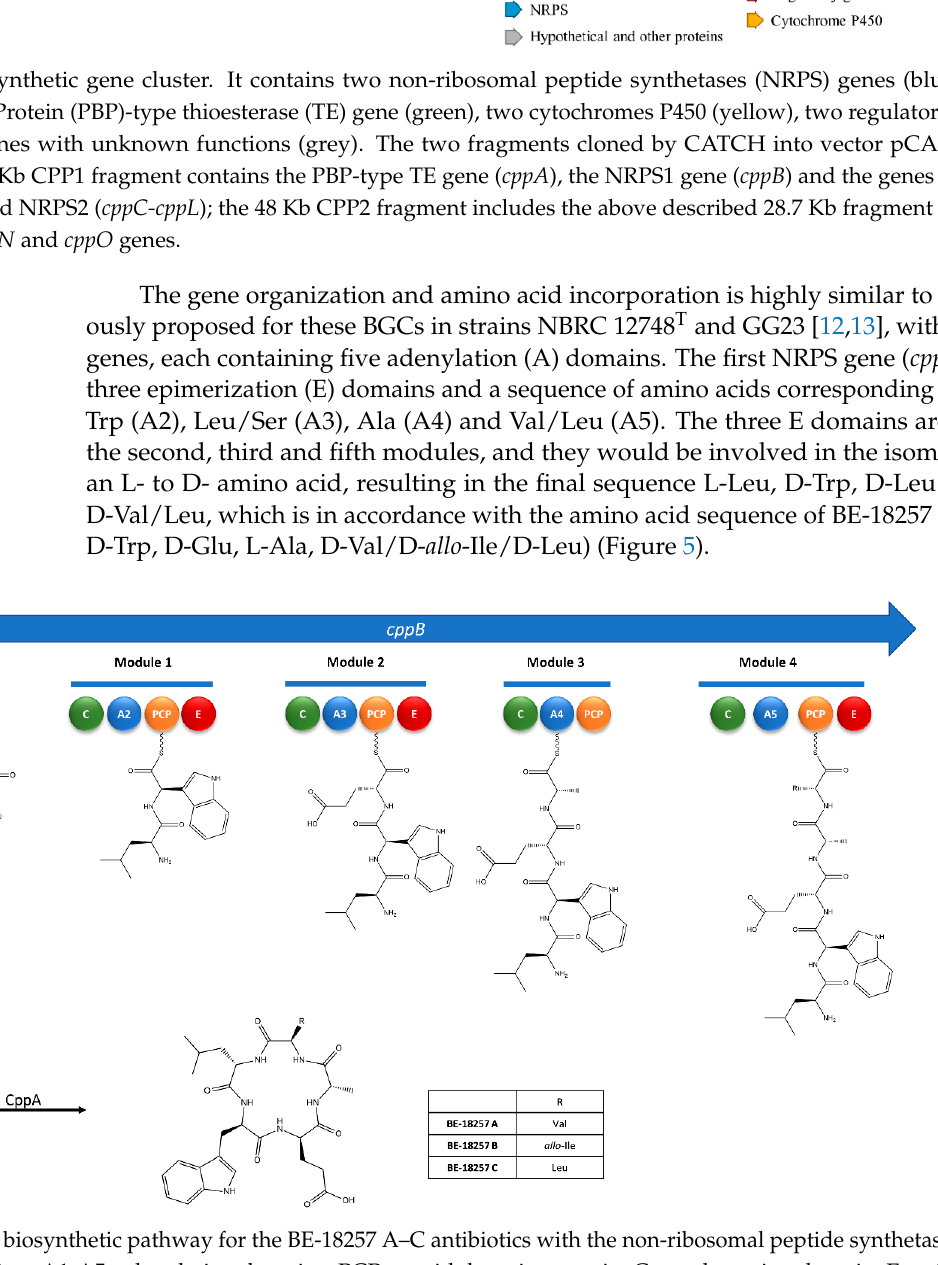
Figure 6. Proposed biosynthetic pathway for the pentaminomycins A–H with the non-ribosomal peptide synthetase CppM modular organization. A1-A5, adenylation domains; PCP, peptidyl carrier protein; C, condensation domain; E, epimerase domain; CppI and CppJ, cytochromes P450; CppA, PBP-type TE. 3.3. Cloning and Heterologous Expression of the cpp Gene Cluster To demonstrate that the identified cpp cluster is involved in the biosynthesis of both BE-18257 A-C and pentaminomycins A–H, we separately cloned two different fragments of the BGC by Cas9-assisted targeting of chromosome segments (CATCH) cloning [23], a main approach to clone long microbial genomic sequences, into vector pCAP01 [33]. This